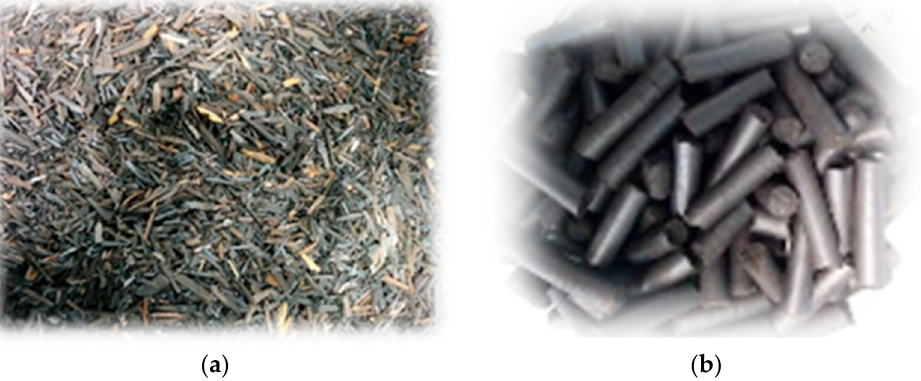
Figure 1. Photos of black spruce residues transformed into ( a ) biochar at 320 °C and ( b ) biochar pellets.